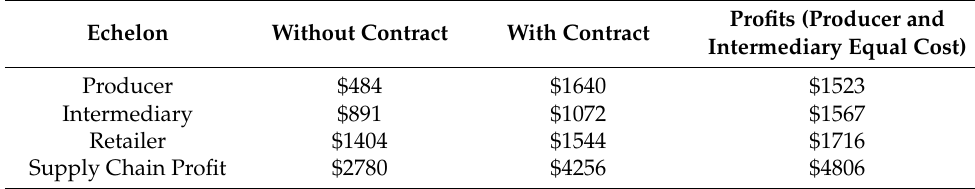
Table 6. Profit Behaviour with costs variation (Source: